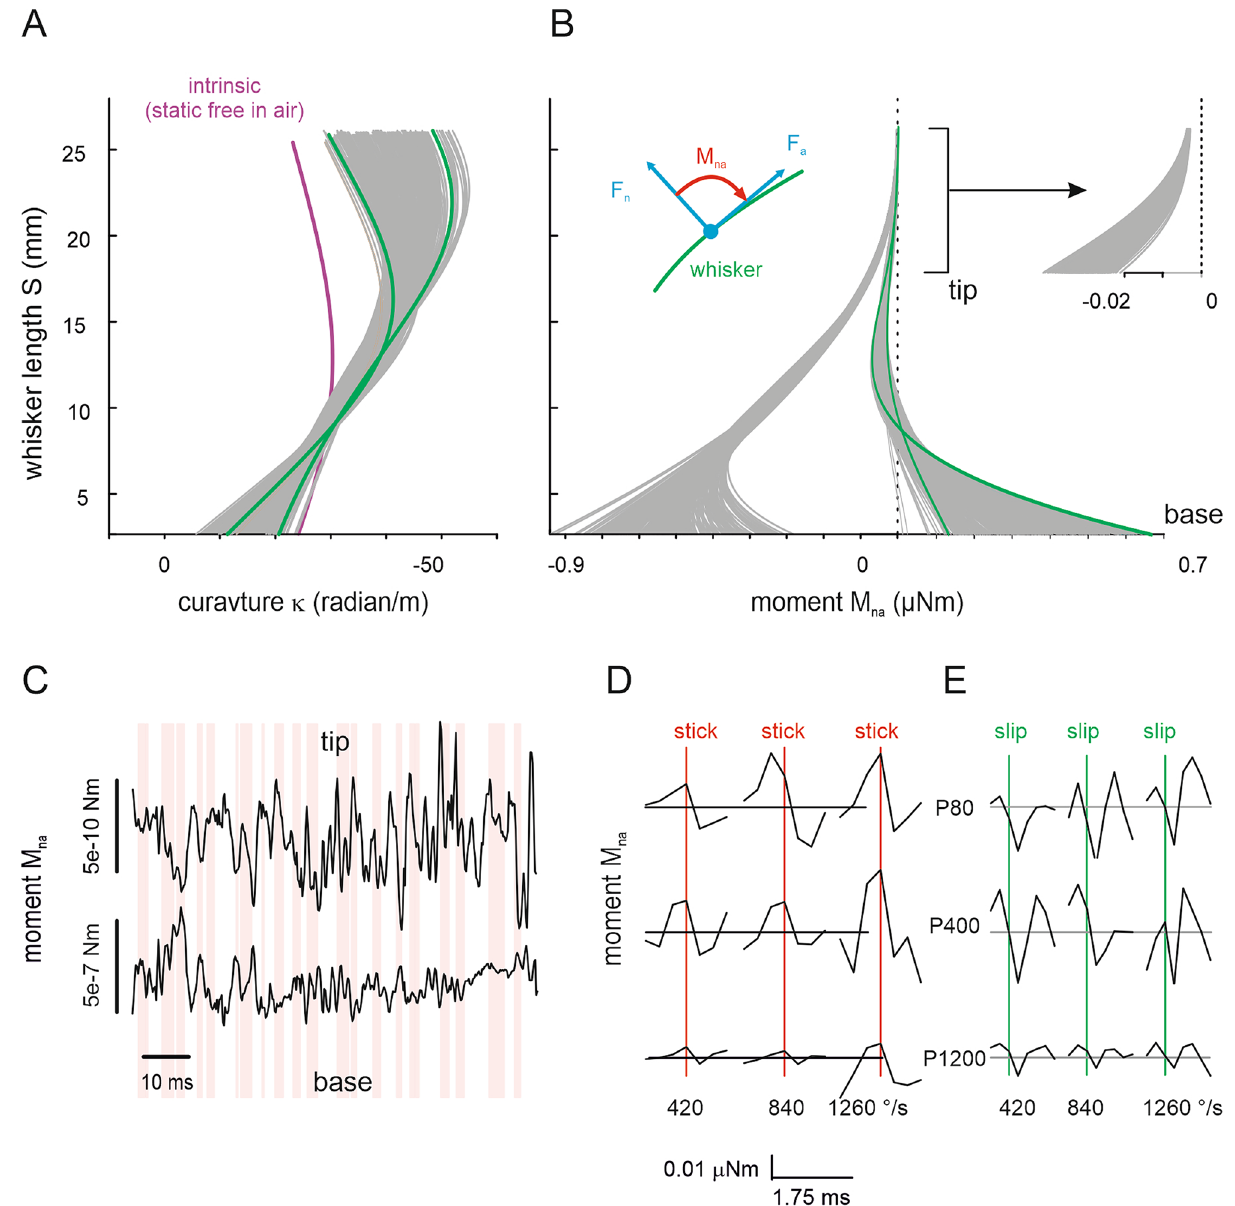
Figure 3. Moment amplification during transmission from whisker tip to base. ( A ) Curvature of whisker in contact with P80 (speed 420°/s). Each line represents one time bin (0.25 ms). Two frames toward the extremes of the curvature are coloured to demonstrate a node of vibration at around 10 mm from the tip (2nd bending mode). ( B ) Moment M na as calculated from Eq. (2). Left Inset: Schematic of normal and axial forces ( F n , F a ) and moment ( M na ) acting in the plane of whisker movement. Moments are negligible at the tip and small negative moment builds up a short distance from the tip. (cf. right inset). The left bundle of lines indicate moment κ i , cf. Equation 2). Two arbitrary frames are highlighted in green to demonstrate calculated using κ (instead κ − the node of vibration. ( C ) Moment M na at tip (s = 24 mm) and base (s = 3 mm) of the whisker (note the three orders of magnitude difference in scale). The red areas indicate periods of sticking ( v < 420 °/s). ( D , E ) Average moment M na with respect to stick (red) and slip (green) events (as identified using the method in Fig. 1B). Nine correlograms taken from traces measured with three different sandpapers and using three driving speeds are